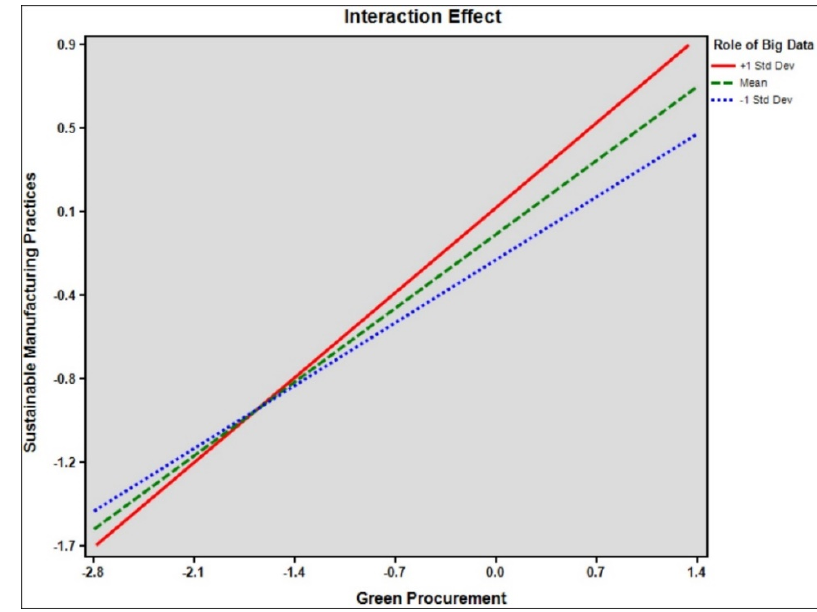
Figure 4. The Moderating Outcome.